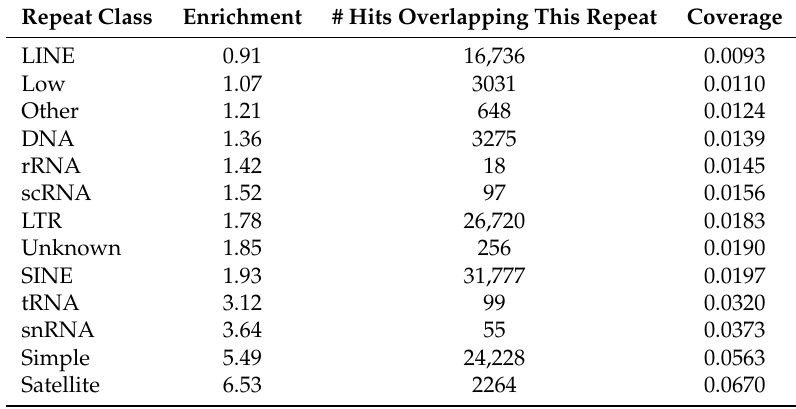
Table 1. Enrichment/ depletion of high-confidence RNAz loci in annotated repeats for the repeat classes defined by RepeatMasker / RepBase. Enrichments are measured in nucleotides covered by RNAz loci in the repeat class, relative to the total length of the repeat class covered by input